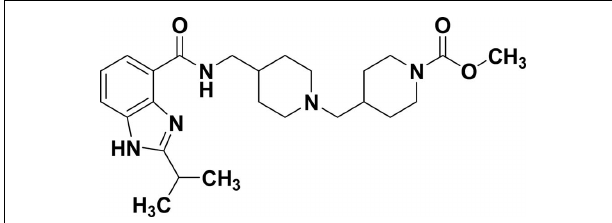
FIGURE 1 |TD-8954 (4-(4-{[(2-isopropyl-1 H -benzoimidazole-4- carbonyl)amino]methyl}-piperidin-1-ylmethyl)piperidine-1-carboxylic acid methyl